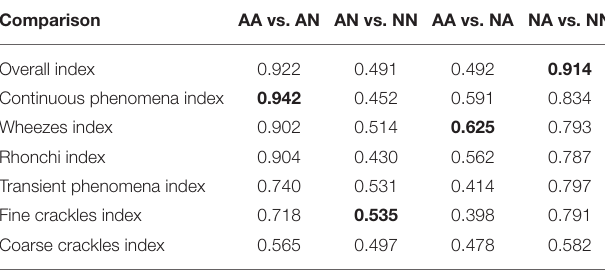
TABLE 4 | AUCs for all index values and four considered comparisons. Comparison